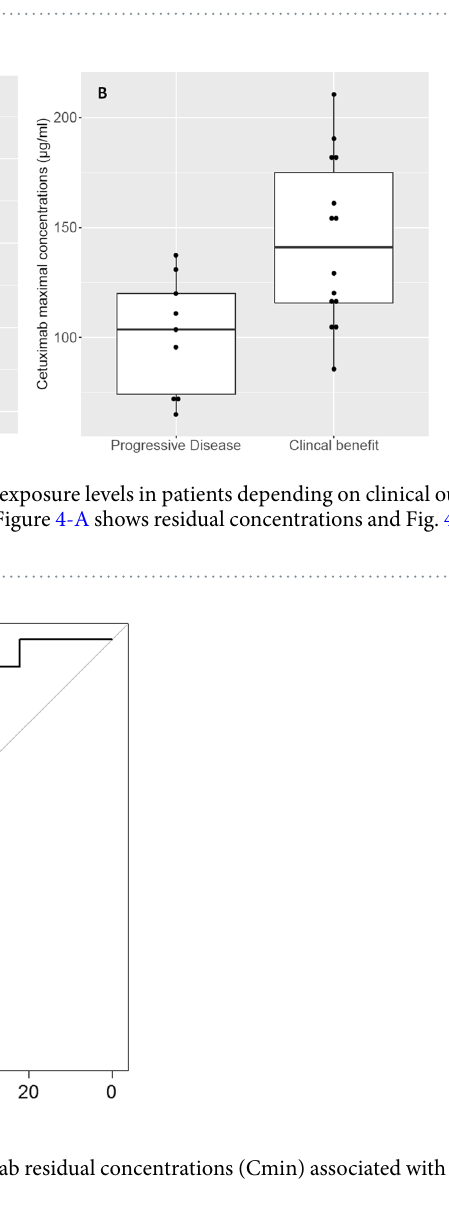
Figure 4. Dispersion of cetuximab concentrations after the end of the infusion (Cmax, right) and immediately before starting the next infusion (Cmin, left).